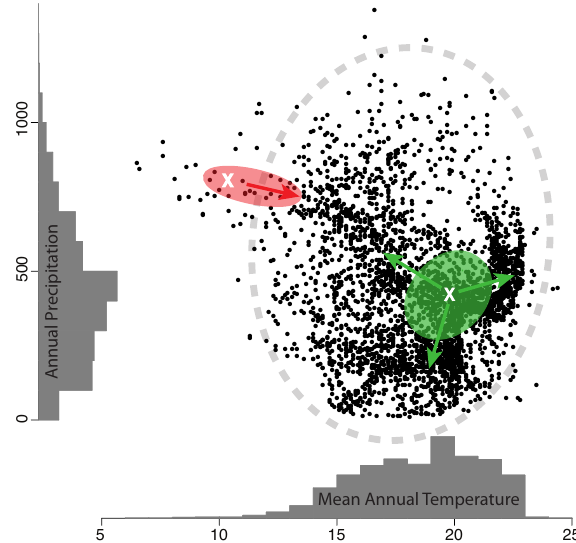
Figure 11. Scatterplot representing a 2-D projection of the cli- matic space of southern Africa for the two variables Tmean ann and prec ann. In green and red are the modern positions of two fictious palaeoarchives. Those two points represent two very dif- ferent situations relative to the climatic space: well-represented (green) vs. rare (red) climate. Reconstructing climate changes for the green palaeoarchive should be more accurate because it can “move” in several directions around its modern climate. However, the only major direction in which the red sample can move is to- wards warmer and drier conditions. Colder temperatures should be “reconstructible” but with an amplitude that may not reflect actual